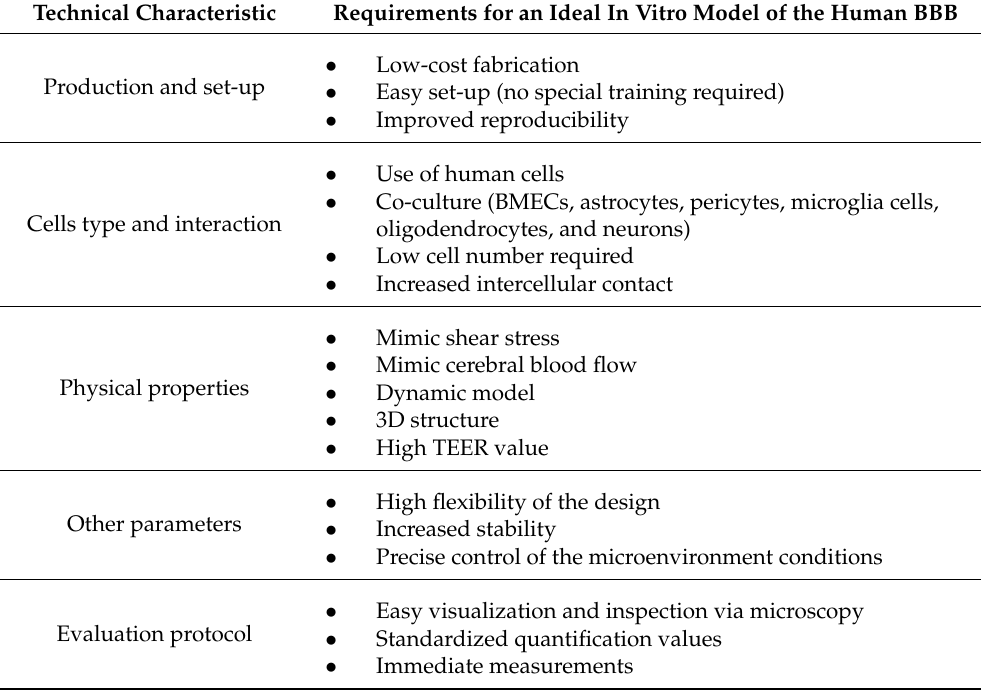
Table 3. Requirements for an ideal (modern) in vitro model of the human